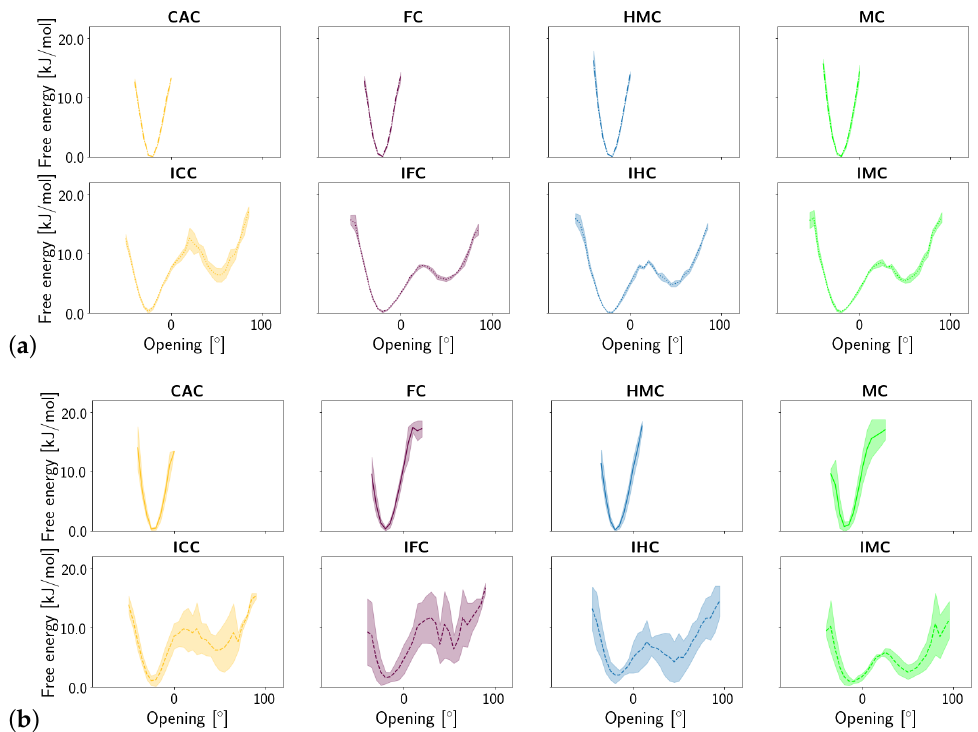
Figure 7. Free energy of the opening angle of the oxidised methyl-cytosine:guanine (G:XC) pair ( a ) in the free DNA in amino form ( top ) and imino form ( bottom ) and ( b ) in the DNA complexed to TDG in amino ( top ) and imino ( bottom )